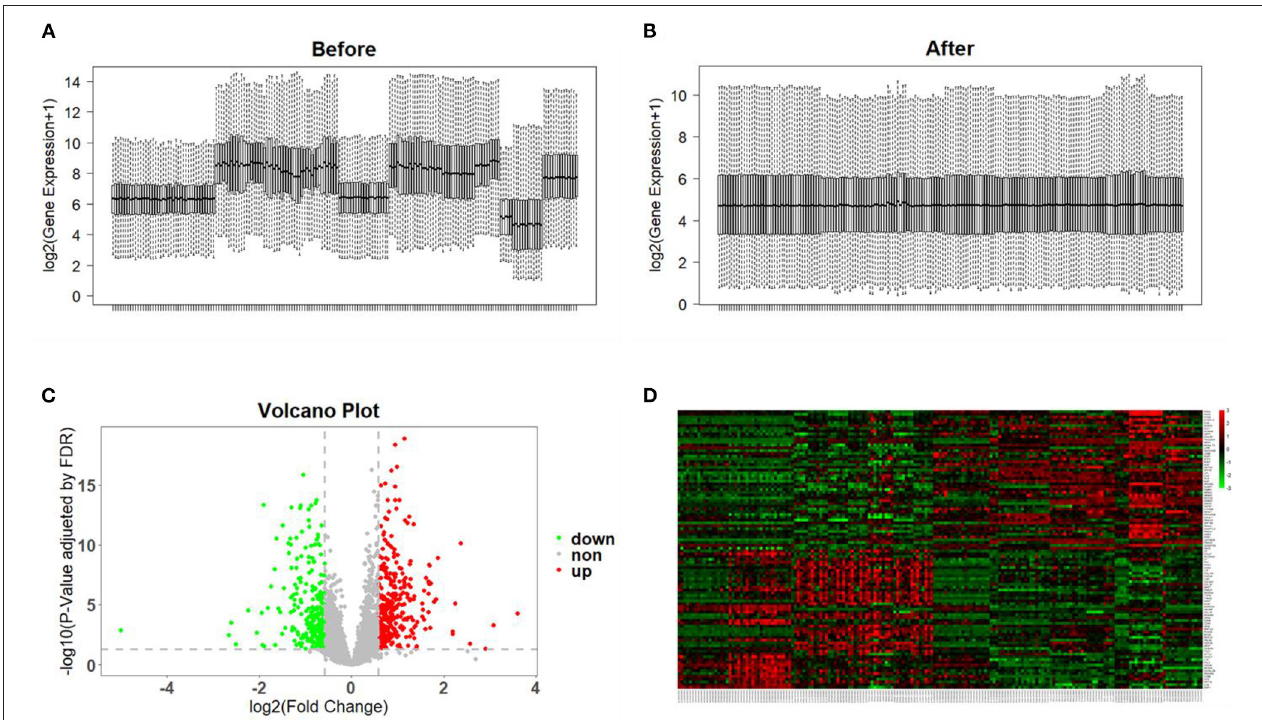
FIGURE 2 | Data preprocessing and identification of DEGs. (A,B) Gene expression data before and after normalization. The horizontal axis represents the sample symbol and the vertical axis represents the gene expression values. The black line in the box plot represents the median value of gene expression. (C) Volcano plot analysis of DEGs. Red represents high expression, green represents low expression, and gray represents no difference. (D) The heatmap of top 100-fold-change DEGs. Red areas represent highly expressed genes and green areas represent lowly expressed genes in glomerular tissues from DN patients compared with normal